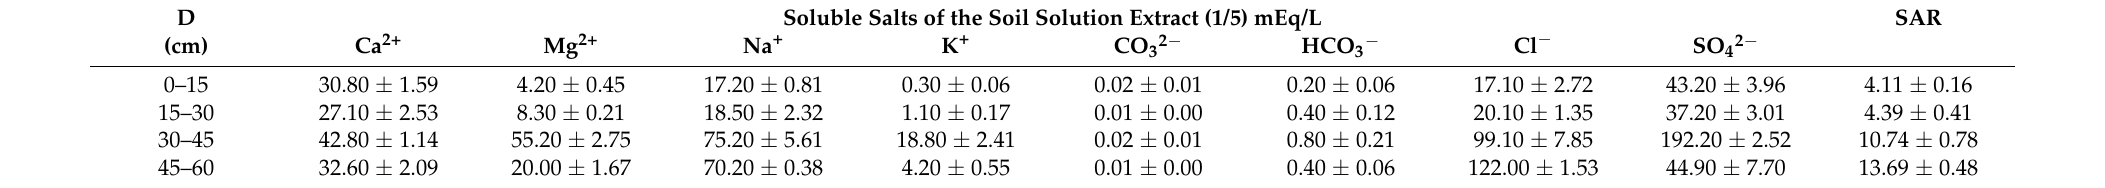
Table 2. Major elements of soil solution in the study site, September 2019 (n = 3).